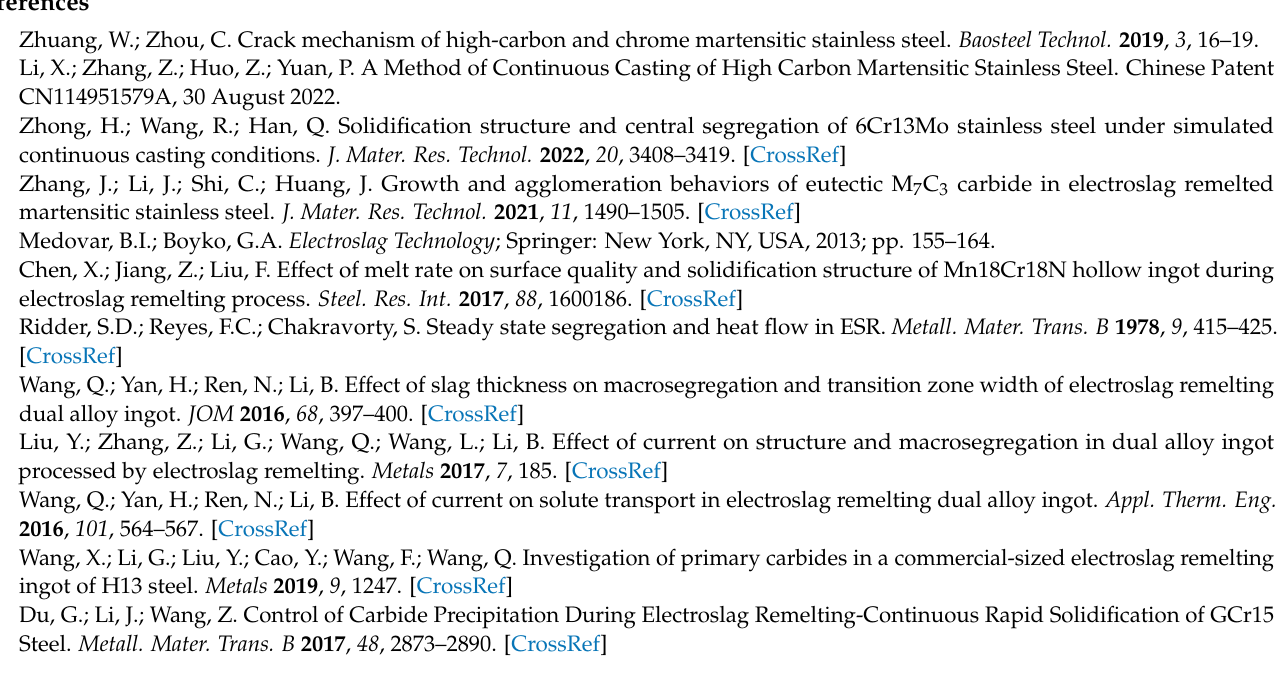
Figure A8. Distribution of SDAS with varying slag thickness: ( a ) 0.08 m, ( b ) 0.10 m, ( c ) 0.12 m and ( d ) 0.14 m.